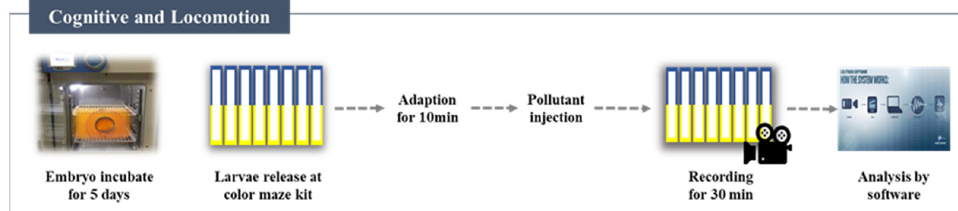
Figure 2. Zebrafish cognitive and locomotive change test model.